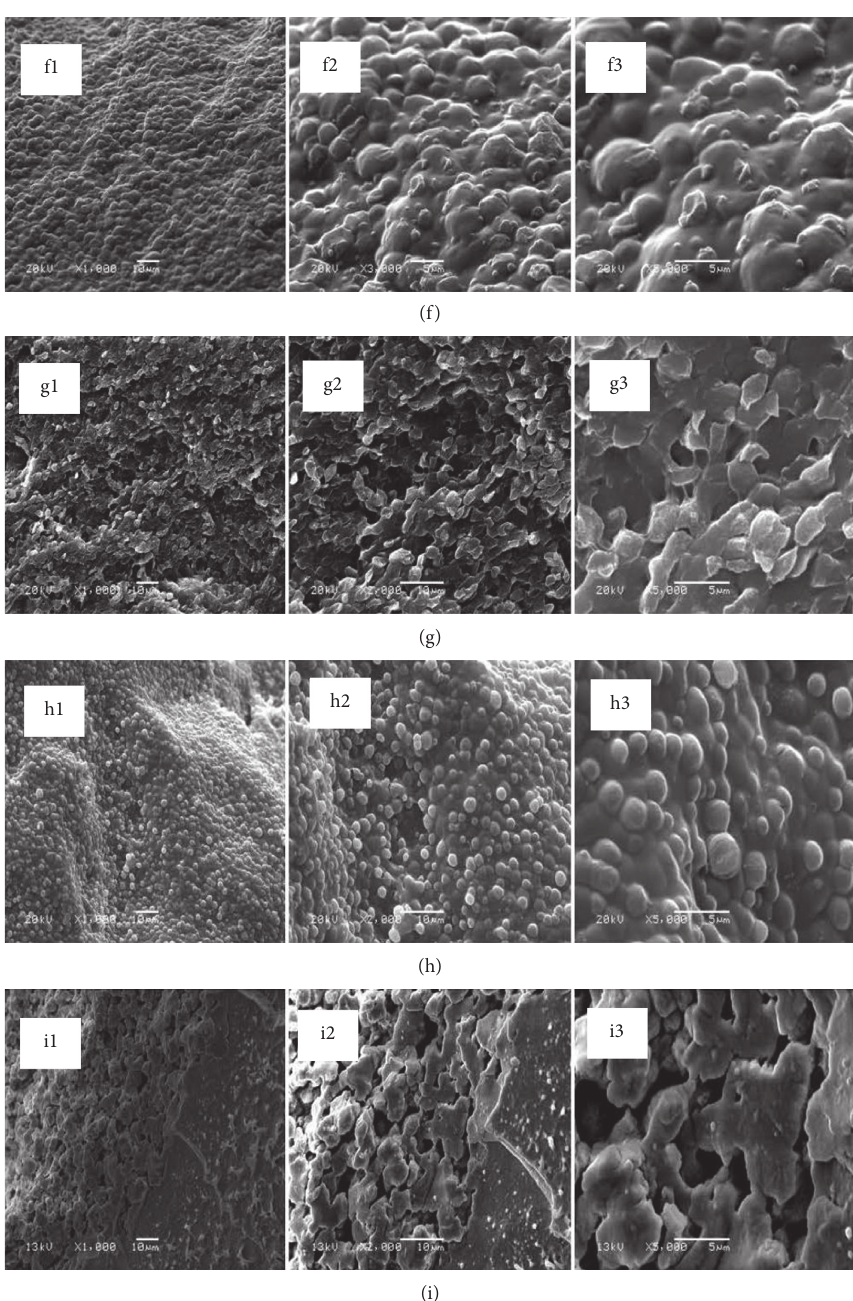
Figure 1: SEM images of fracture surfaces at various magnifications: (a) neat MC film; (b) MC/PET (99 :1) film; (c) MC/PET (97 : 3) film; (d) MC/PET (95 : 5) film; (e) MC/PET (9:1) film. (f) MC/PET (7: 3) film; (g) MC/PET (1 :1) film; (h) MC/PET (3:7) film; and (i) MC/PET (1: 9)